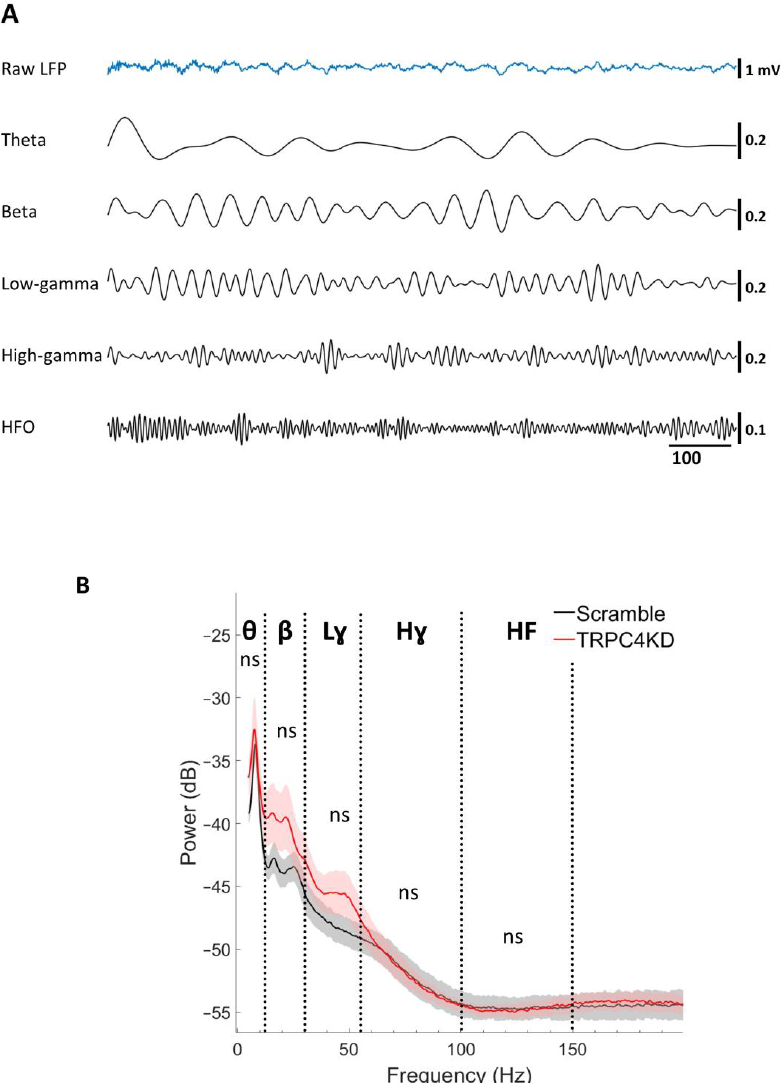
Figure 2. ( A ) An example of LFP and underlying theta, beta, low gamma, high gamma oscillations, and HFO in the order from top to bottom. Theta: 7-12 Hz, Beta: 15–29 Hz, Low-gamma: 30–55 Hz, High-gamma: 65–100 Hz, High-frequency oscillation (HFO): 100–150 Hz. ( B ) Mean power spectrum comparison between groups (independent samples t -test, p = 0.513 for theta, p = 0.512 for beta, p = 0.258 for low-gamma, p = 0.936 for high-gamma, p = 0.938 for HFO). ns, not significant. Scramble (black): n = 6; TRPC4 KD (red): n = 6. Filled area indicates standard error. ns: not significant.